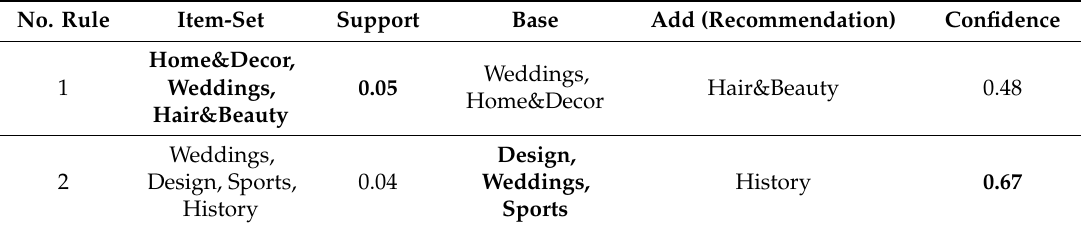
Table 3. Example of association rules using DB2 dataset. In the first row, the text in bold indicates those parameters evaluated for method A, and in the second row for method